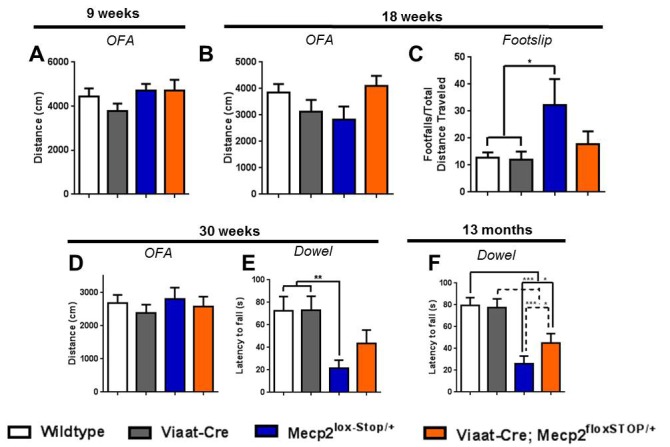
Female rescue mice show partial rescue particularly at late ages.(A–C) At 9 weeks of age, no differences in locomotion were noted (A, n = 11–17 per genotype). (B) 18-week-old female mice of all genotypes showed similar levels of motor activity in the open field assay. (C) Mecp2lox-Stop/+ females exhibited more footslips, whereas rescue females were more coordinated (n = 8–18 per genotype). (D) Even at 30 weeks of age, females of all genotypes exhibited similar levels of motor activity (though less than younger mice; n = 14–17 per genotype). (E–F) Mecp2lox-Stop/+ females were unable to remain balanced on a dowel at 30 weeks (E, n = 14–18 per genotype) or 13 months (F, n = 25–35 per genotype) of age, but rescue mice performed significantly better at both time points. Error bars show SEM. *p<0.05 **p<0.01 ***p<0.001.